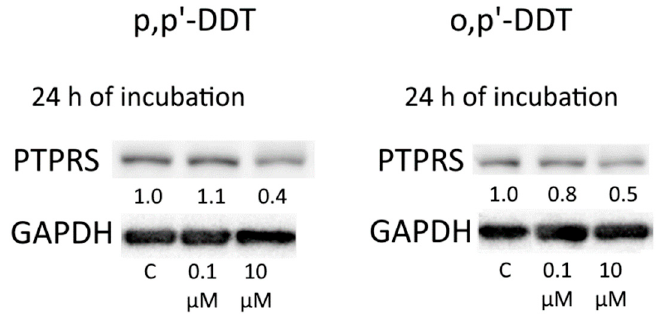
Figure 10. Western blot analysis of PTPRS in cells incubated with p,p ′ -DDT and o,p ′ -DDT. The numbers under PTPRS bands denote fold change in the protein level as compared to the first band (control); each data point was normalized to the corresponding GAPDH band. We present data from one of three independent experiments (which yielded similar results). The levels of proteins APAF1 and OXTR declined in the cells treated with endosulfan for 24 h, and TP53INP1, APAF1, and OXTR levels decreased in the cells treated for 48 h (Figure 11).